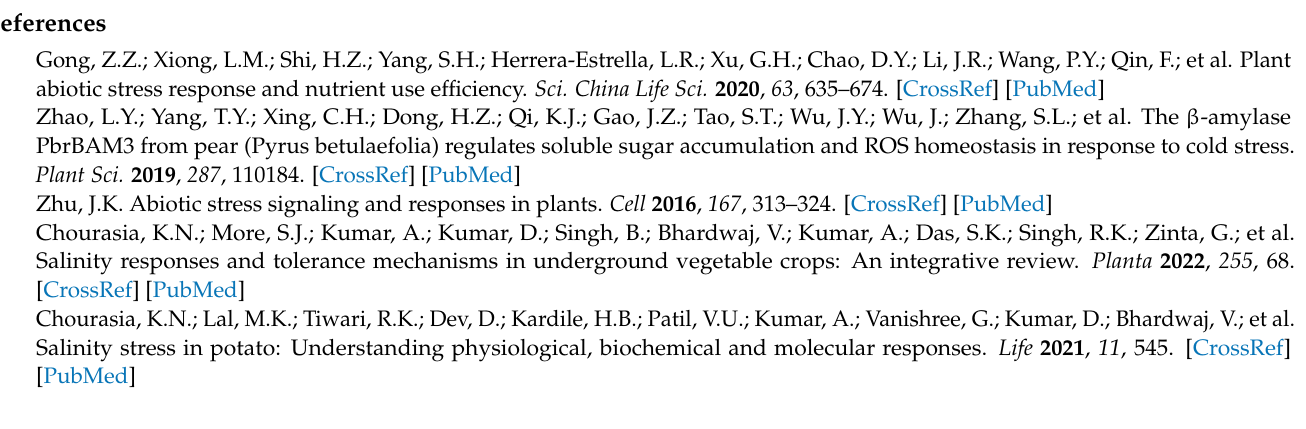
KIbB1; Figure S2: Expression analysis of KIbB1 in different tissues; Figure S3: PCR identification of KIbB1 transgenic plants; Table S1: Primers used in this